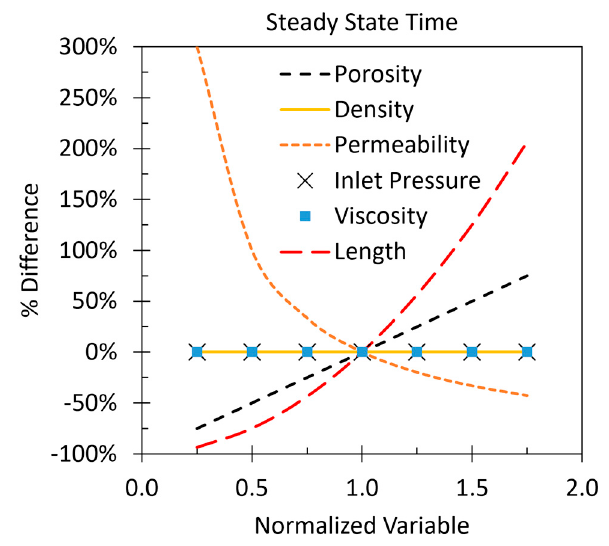
Figure 8. Parametric study of the system variables with respect to steady-state time.